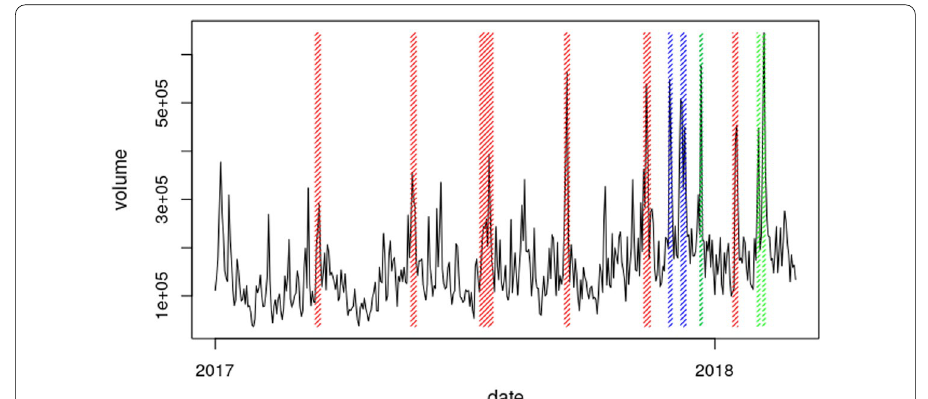
Fig. 2 Aggregated volume with highlighted end of month events and large scale